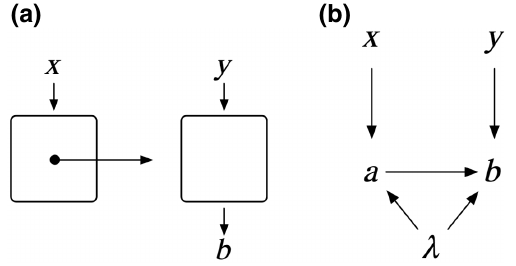
FIG. 1. Operational and causal representations of a PAM sce- nario. On the left, the black-box shows a preparation, conditioned on input x , being sent to a measurement device with measurement choice y and output b . On the right, the DAG turns explicit the unobservable variables a and λ in the causal